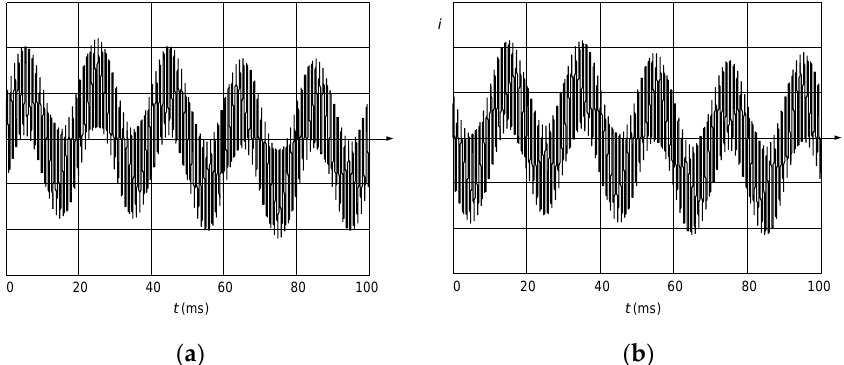
Figure 3. Mixed-frequency waveform composed of components presented in Table 1; phase angle of the I 1kHz and I 10Hz is 0°; phase angle of the I fund (50 Hz) is: ( a ) 0°; ( b ) 180°.